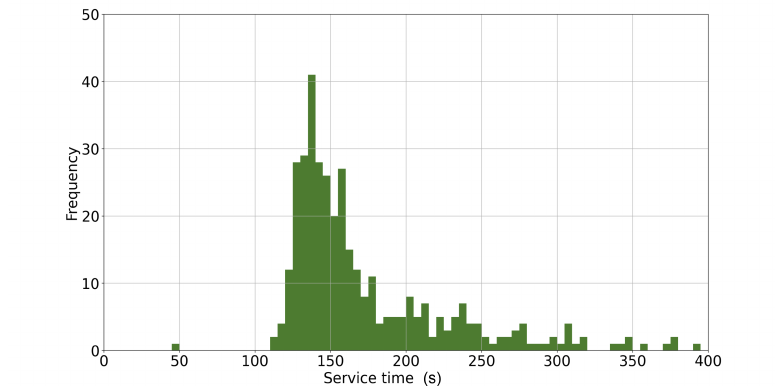
Figure 12. Service